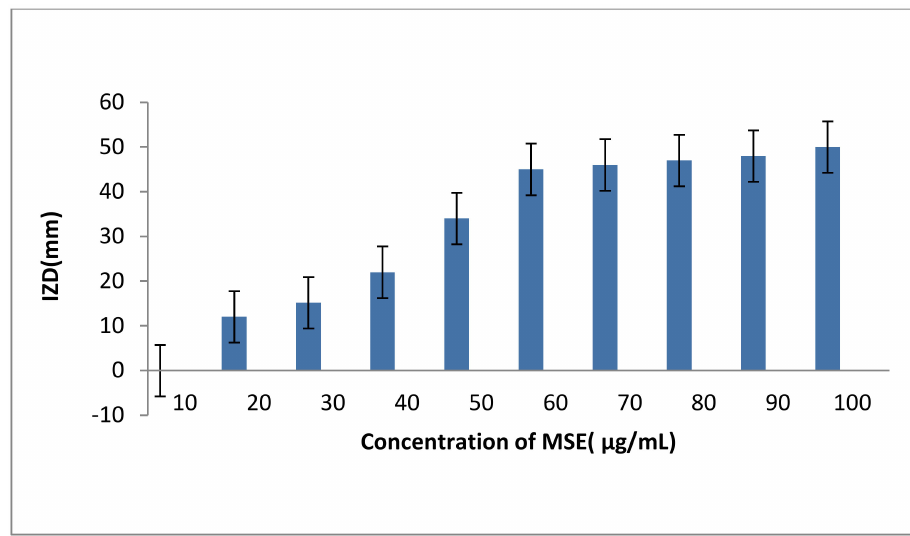
Figure 5. Determination of Minimum inhibitory concentration (MIC) of MSE against S. aureus LC 554891. All values reflect the mean values of three replicates and standard deviations.